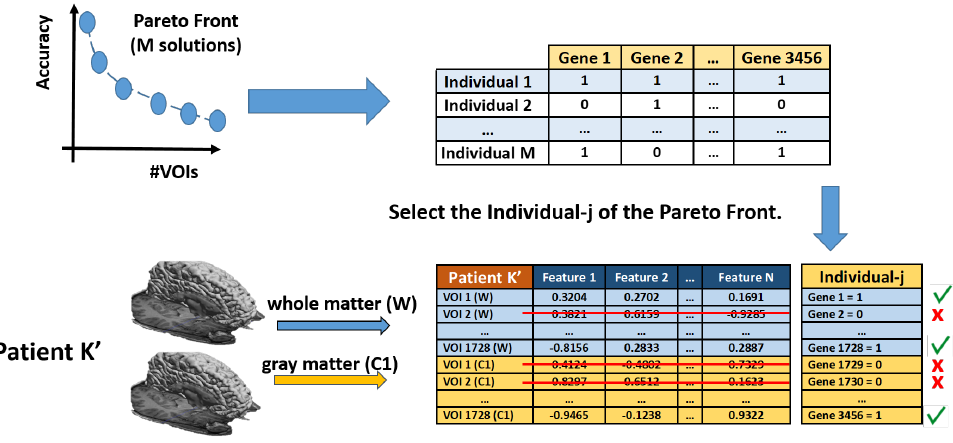
Figure 7. Binary coding used by the MOE algorithm for the selection of the most relevant VOIs in gray and whole